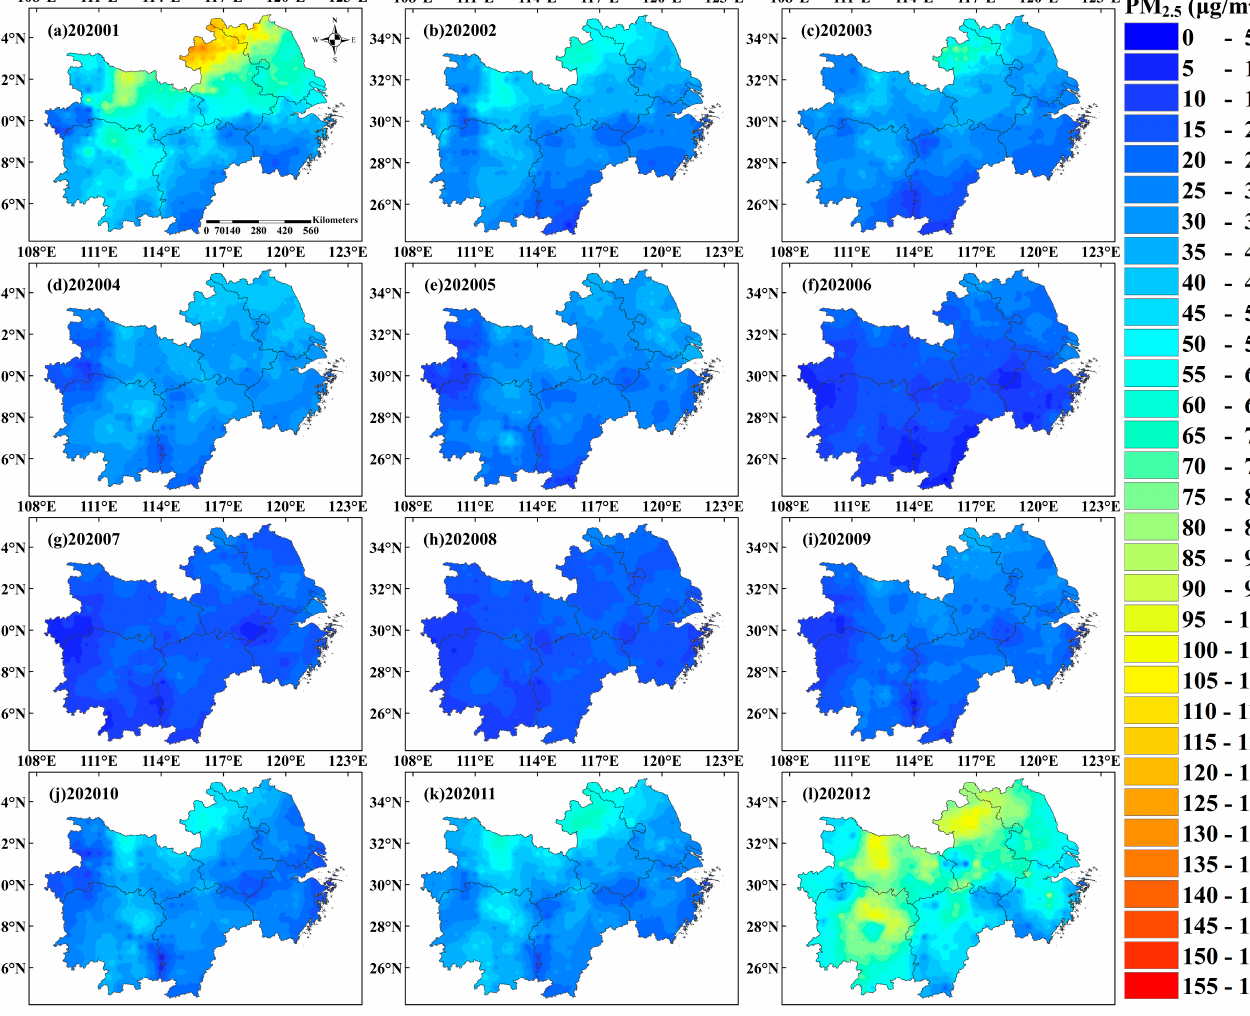
Figure 13. The spatial distribution of PM 2.5 concentrations from January to December 2020 ( a – l ) is shown by different color bands indicating the distribution of PM 2.5 concentrations.